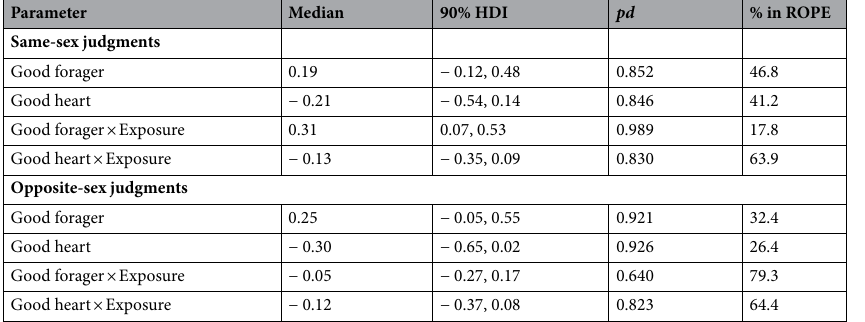
Table 3. Parameter estimates from the marginal posterior distributions of the model analyzing same- and opposite-sex judgments. The point estimate is the median value of the marginal posterior distribution. The 90% highest density interval (HDI) is the smallest interval that contains 90% of the posterior distribution, pd is the proportion of the posterior in the same direction as the median, and % in ROPE is the proportion of the posterior distribution falling between the region of practical equivalence (− 0.18).